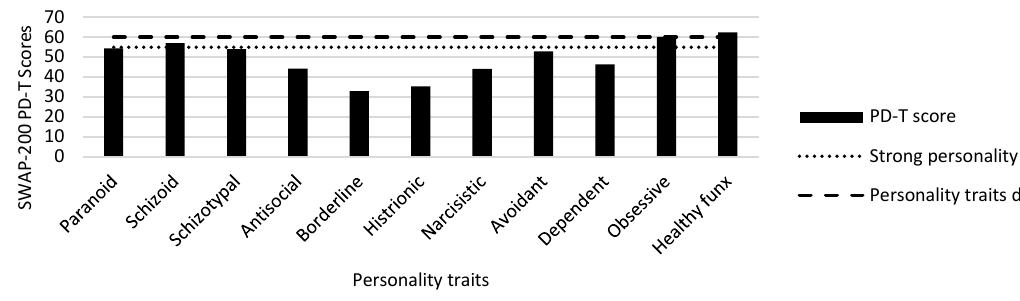
Figure 7: Margherita’s SWAP-200 6-month follow-up PD-T score